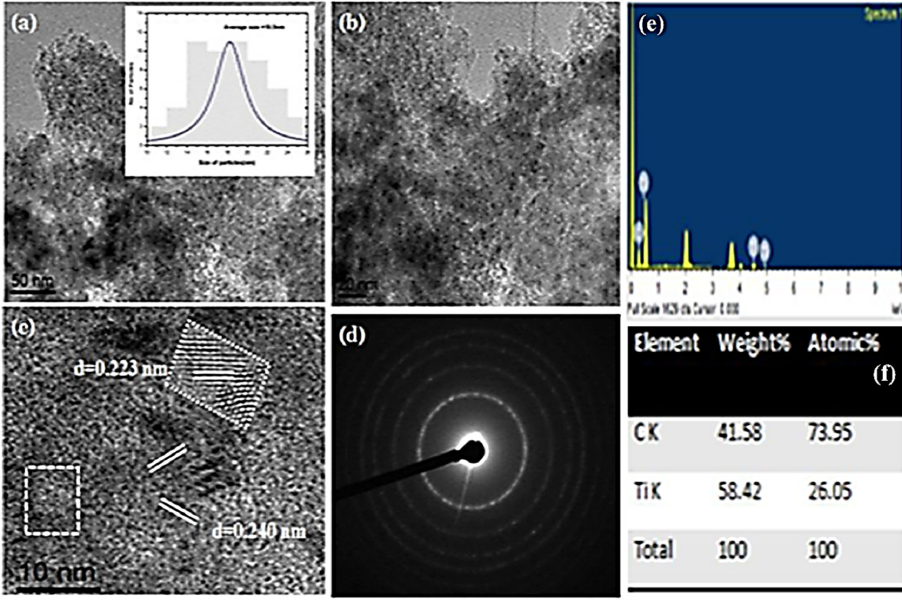
Figure 4. HRTEM and EDX images of synthesized AC-TiO 2 NPs, Image ( a , b ) are TEM images, with histogram, lattice parameter ( c , d ) SAED pattern of AC-TiO 2 , ( e , f ) shows the EDX image with atomic percentages. The average size displayed by the histogram is found to be 25.4 nm and crystalline behaviour was estimated by the analysing the SAED which shows a higher solid-state for the AC- supported TiO 2 . The obtained values for the pure and supported TiO 2 particles